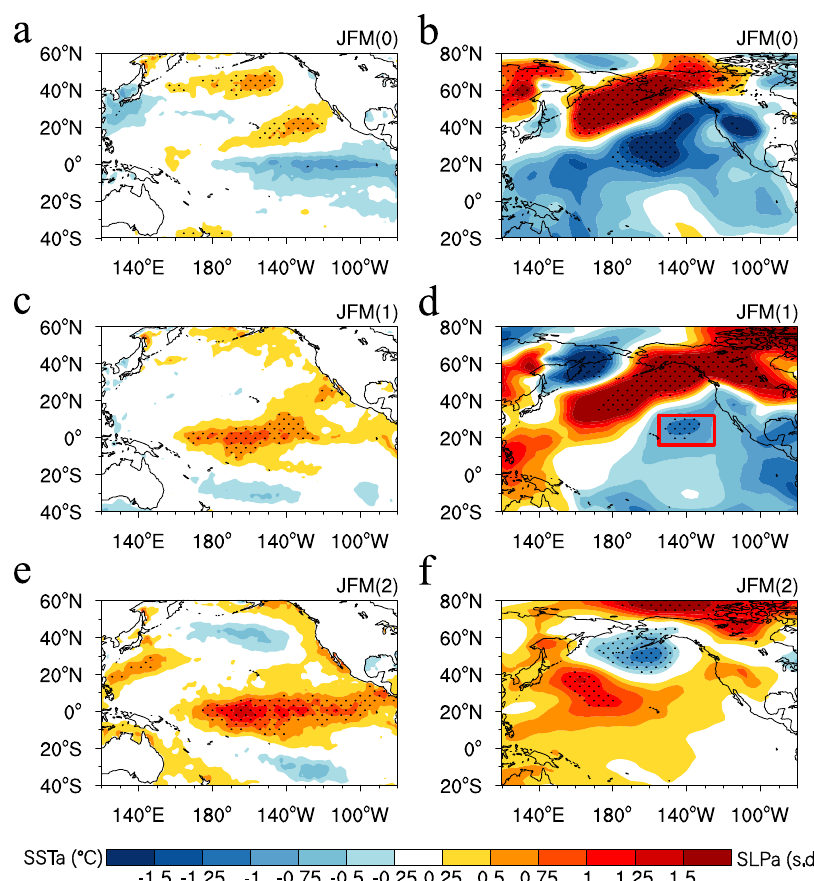
Fig. 2 Evolutions of SST and SLP anomalies composited for multi-year El Niño events over a 3 yr period derived from HadISST and NCEP1 SLP datasets. a , b JFM(0) SST and SLP anomalies, respectively. c , d JFM(1) SST and SLP anomalies, respectively. e , f JFM(2) SST and SLP anomalies, respectively. The red box in d denotes the region used to compute the SLP index over the Hawaiian region (SLP HI ; 155° – 125°W, 16° – 32°N). In a − f , dots indicate SST and SLP anomalies signi fi cant at the 95% con fi dence